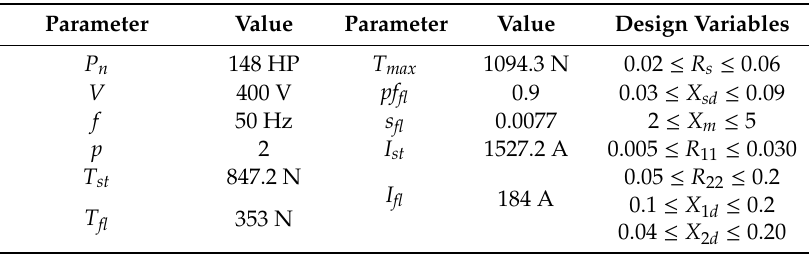
Table 11. Data of Machine 2 [20].